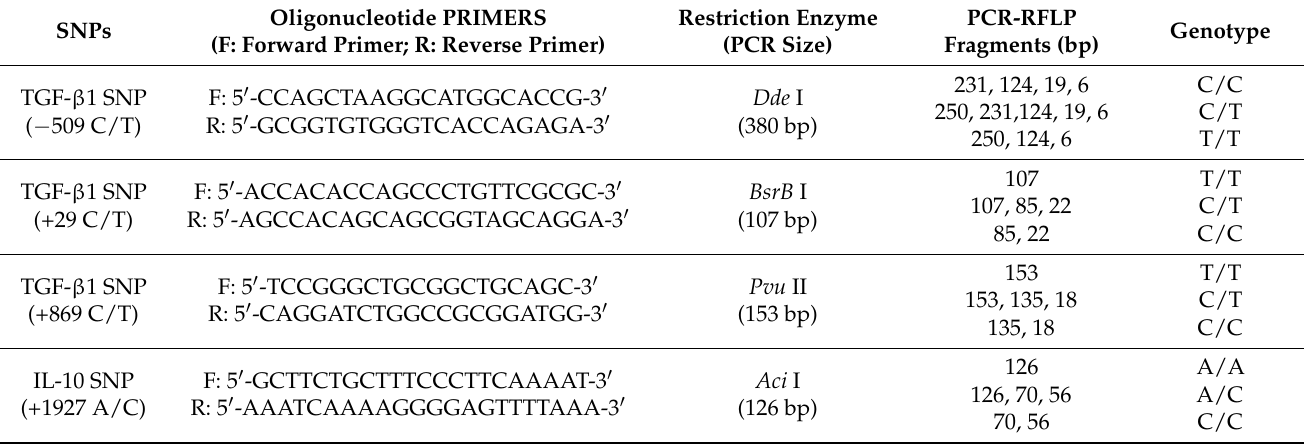
Table 1. Description of the four SNPs within the TGF- β 1 and IL-10 genes and the prediction of genotypes by PCR- RFLP fragments.